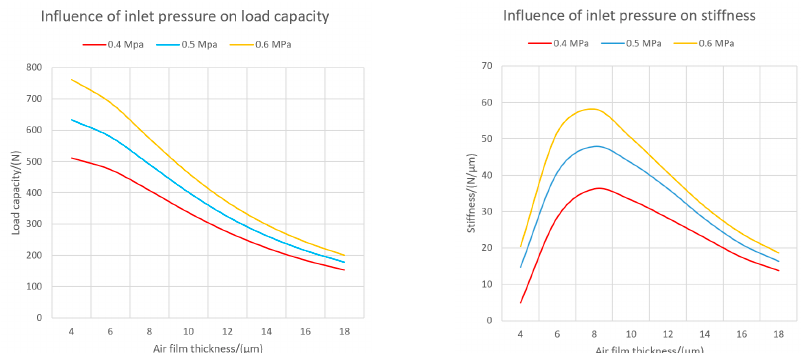
Figure 8. Load capacity and stiffness under different supply pressures.